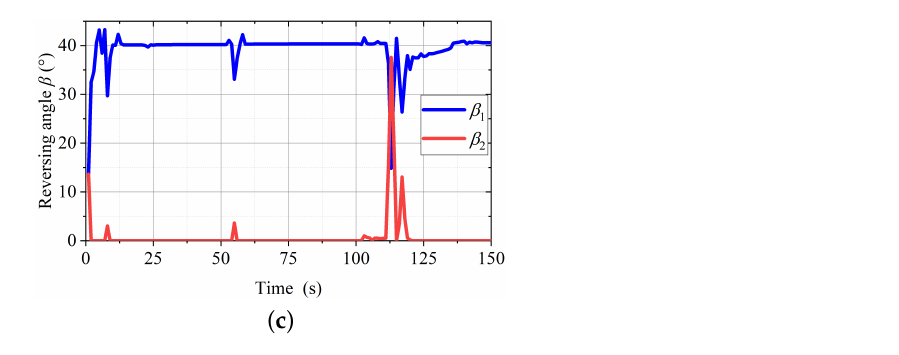
Figure 16. Allocation results of waterjets actuators in the sideway movement. ( a ) Engine speed allocation results; ( b ) Steering angle allocation results; ( c ) Reversing angle allocation